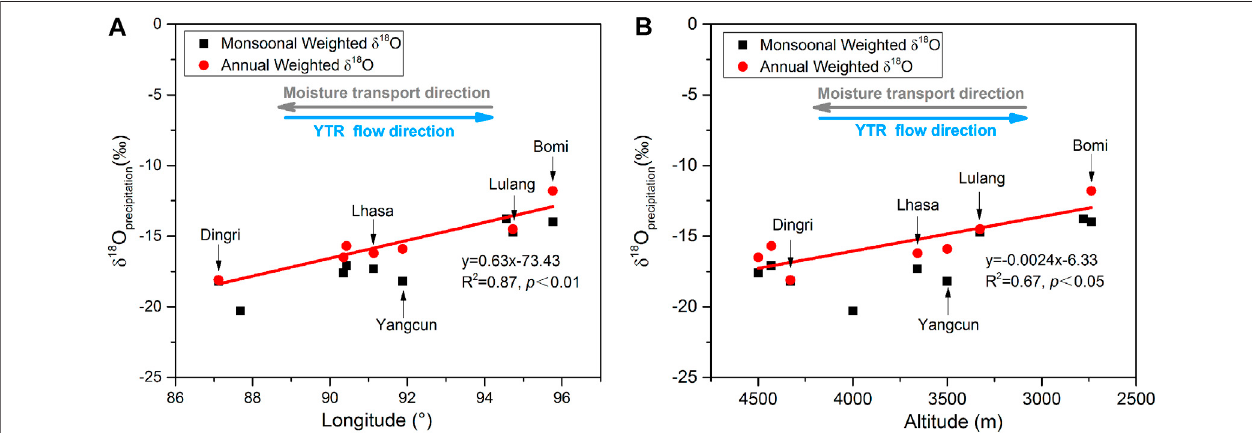
FIGURE 6 | Relationship of δ 18 O of precipitation to (A) longitude and (B) altitude. Red dots (cid:1) annual weighted δ 18 O; black squares (cid:1) monsoonal weighted δ 18 O of precipitation; red lines (cid:1) linear fi t of annual weighted δ 18 O in precipitation with longitude and altitude. As moisture moves westward, altitude gradually increases and isotopic compositions of precipitation progressively decrease (data from Wang et al. (2000) and Yao et al. (2013)).